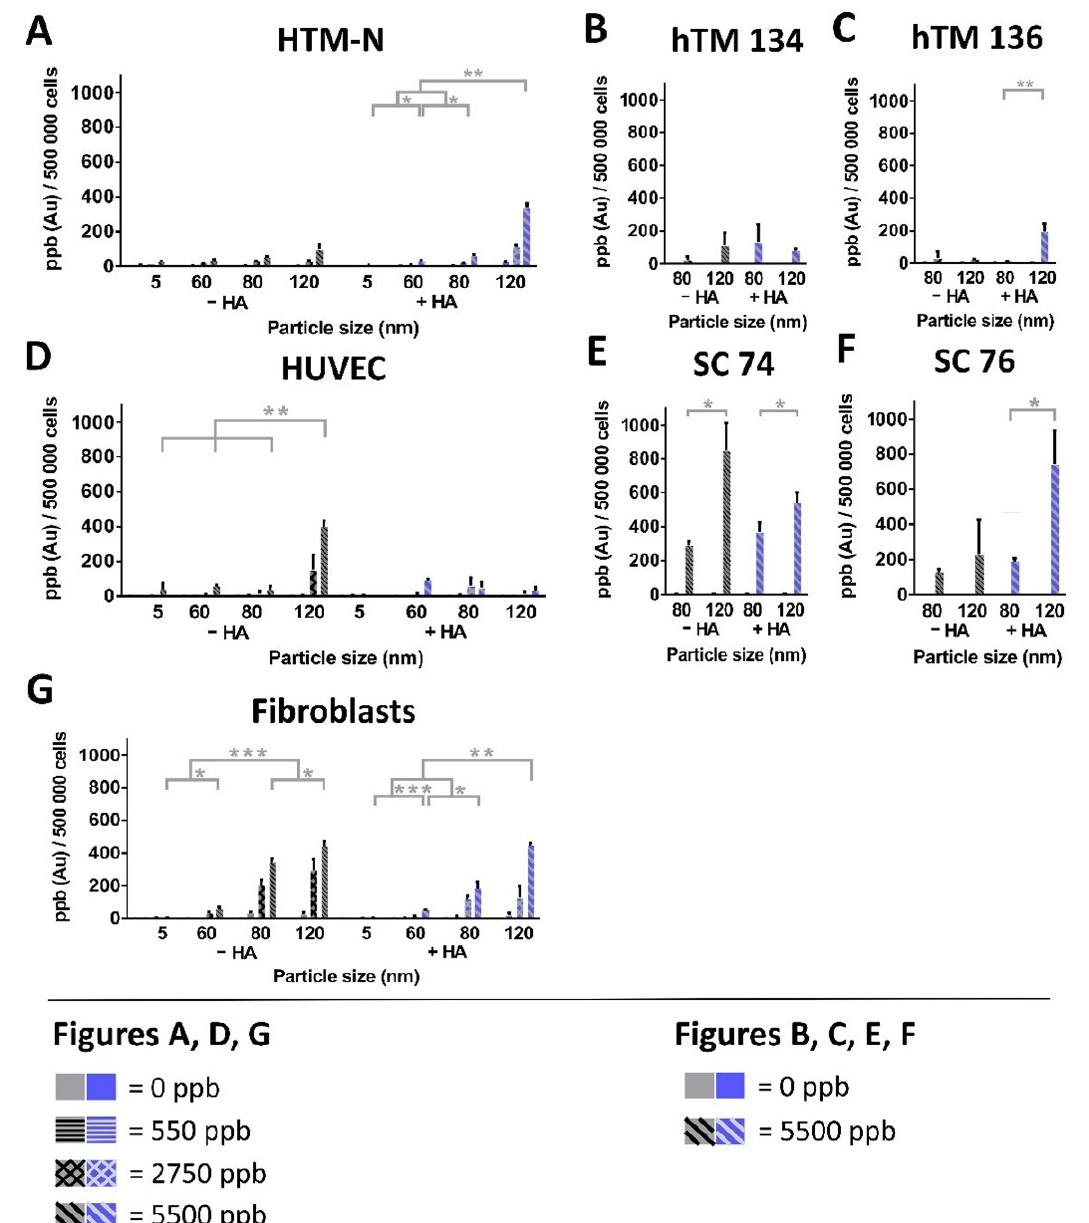
Figure 6. Uptake of AuNPs and HA-AuNPs into different cell types. Different cell types were used to determine the amount of uptake of AuNPs versus HA-AuNPs. Grey bars represent the AuNPs, and blue bars represent the HA-AuNPs. For HTM-N cells, HUVECs and fibroblasts ( A , D , G ), three different NP concentrations were applied (550, 2750 and 5500 ppb). For primary hTM and SC cells ( B , C , E , F ), only the highest NP concentration was evaluated (5500 ppb). Larger particles seemed to increase the uptake of gold. ( A ) For HTM-N cells, the gold content increased with the NP concentration and the uptake of HA-AuNPs was tendentially higher compared to AuNPs. ( B ) Primary hTM134 cells did not exhibit any significant tendency between the different particle species. ( C ) Primary hTM136 cells demonstrated a higher uptake for the 120 nm HA-AuNPs. ( D ) HUVEC cells showed a lower uptake of HA-AuNPs compared to AuNPs. The 120 nm AuNPs were taken up significantly better than smaller AuNPs. ( E ) Primary SC74 cells displayed higher uptake rates for 120 nm AuNPs or HA-AuNPs, compared to the corresponding 80 nm particles, respectively. ( F ) Primary SC79 cells showed a higher uptake of 120 nm HA-AuNPs compared to 80 nm HA-AuNPs. ( G ) Fibroblasts featured a tendency to have larger particles for both surface modifications and several particle sizes . Statistically significant differences are denoted by *, ** or *** ( p < 0.05, p < 0.01 or p < 0.001, respectively).